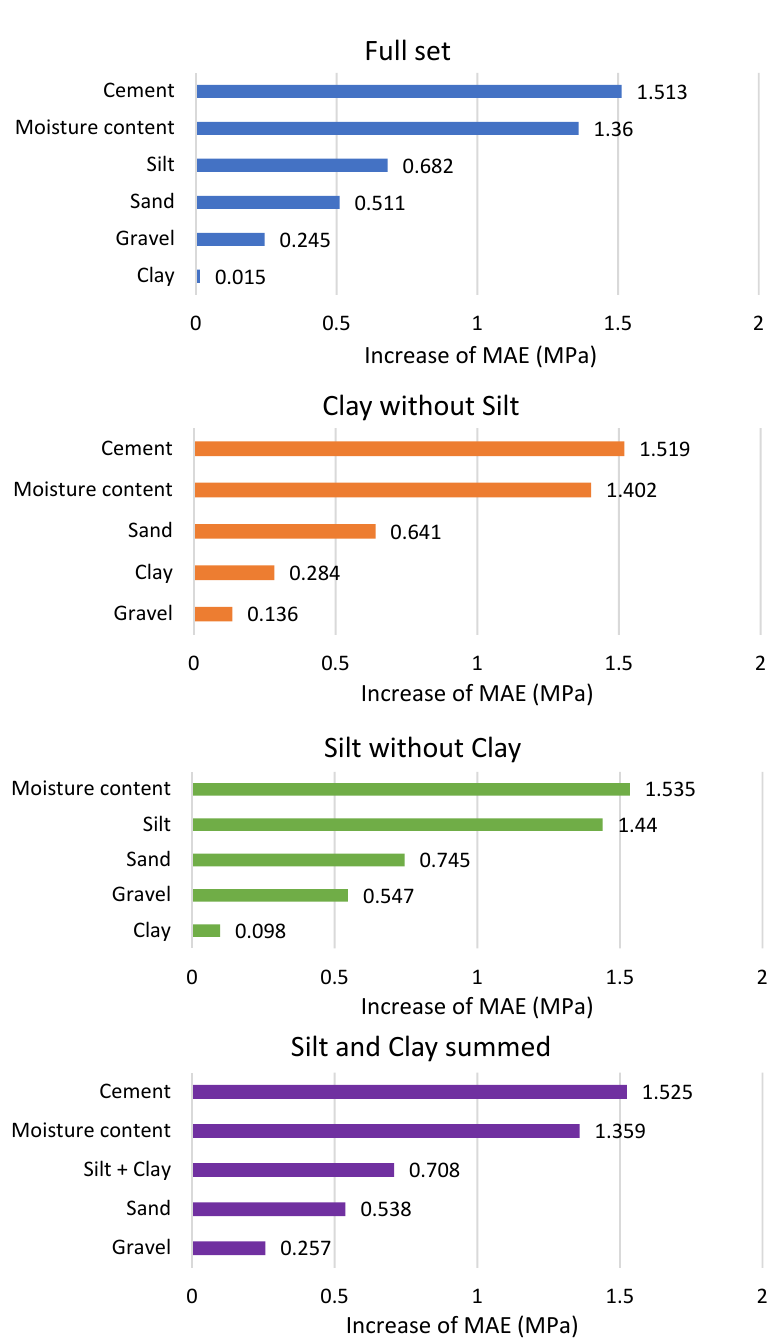
Figure 5. Feature importance plots from drop-out loss based on the DTR model and different datasets.